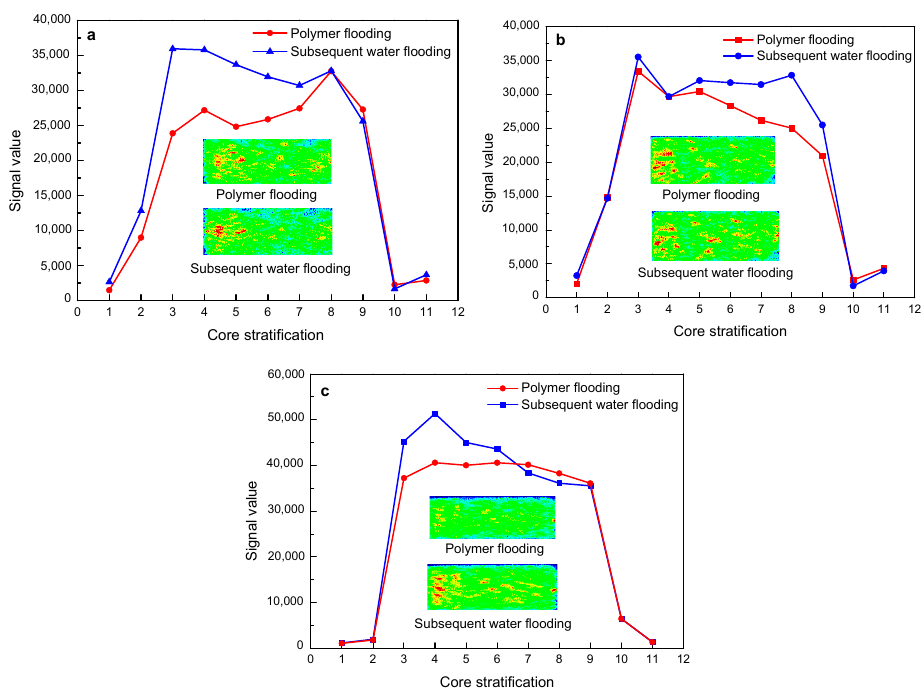
Figure 14. The change characteristics of NMR layering signal and imaging of 25 million molecular weight polymer solutions in rock cores with different permeability after polymer flooding and subsequent water flooding: ( a ) 500 mD core; ( b ) 1000 mD core; ( c ) 2000 mD core.